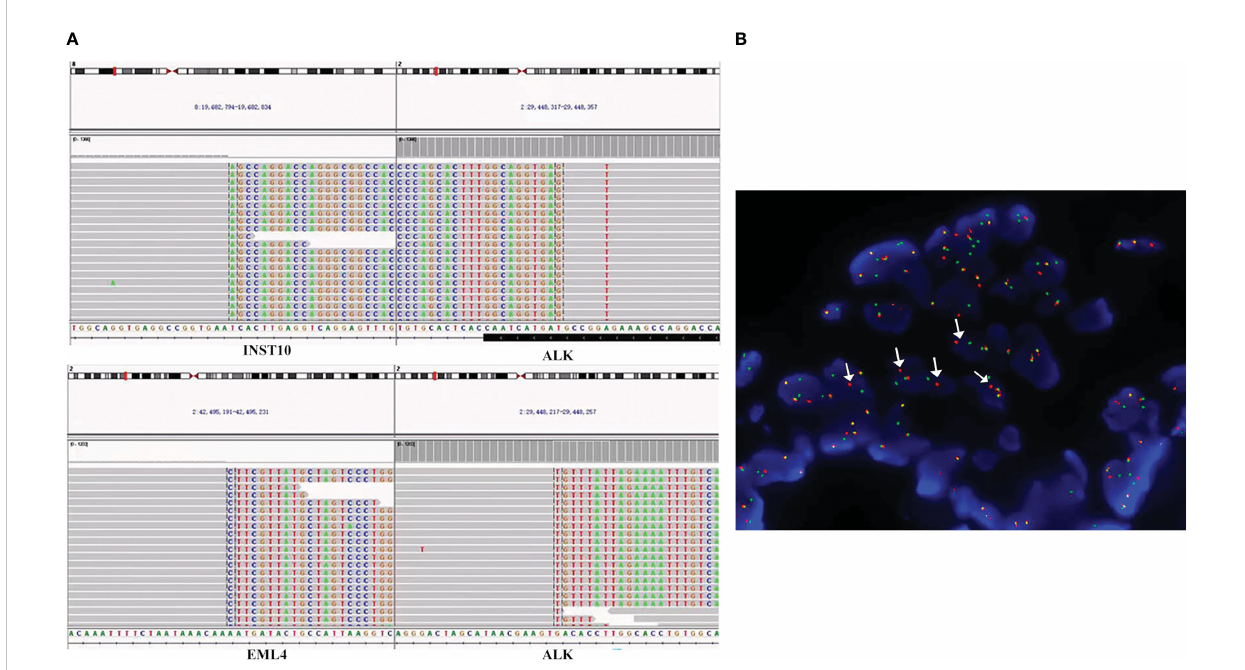
FIGURE 2 ALK fusions detected by the targeted NGS assay and FFPE FISH. (A) Sequencing reads of INTS10-ALK fusion and EML4-ALK fusion rearrangements at the time of diagnosis. Taking the INTS10-ALK fusion as an example, the top part of the picture describes the position of the gene on the chromosome. INTS10 on chromosome 8 (8 exons) fused with ALK on chromosome 2 (20 exons). In the bottom part, each row represents a read. Furthermore, for each row, the normal bases of each gene in each row are in gray, and the colored bases belong to another gene. For example, the gray bases in INS-10 are normal bases, and the colored mutilation bases in INST-10 belong to ALK. Similarly, the gray bases in ALK are normal bases, and the colored mutation bases in ALK are part of INST-10 bases. The same principle can annotate the sequencing results of EML4-ALK. (B) FISH result. Using ALK break-apart probe shows ALK rearrangements. Green signals represent the 5 ′ -ALK gene, red signals represent 3 ′ -ALK, and yellow signals represent intact ALK gene. Therefore, arrows point to ALK rearrangements because of the separation of red and green signals. FISH, fl uorescence in situ hybridization; NGS, next-generation sequencing; FFPE, formalin- fi xed paraf fi